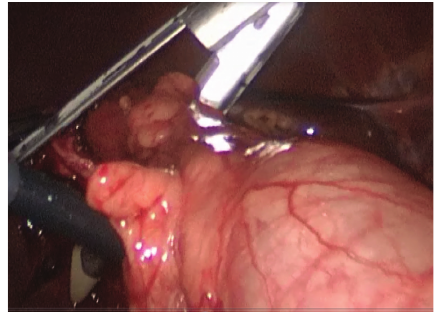
Figure 1: Cholecystocolic fistula between fundus of gallbladder and hepatic flexure of colon is seen.